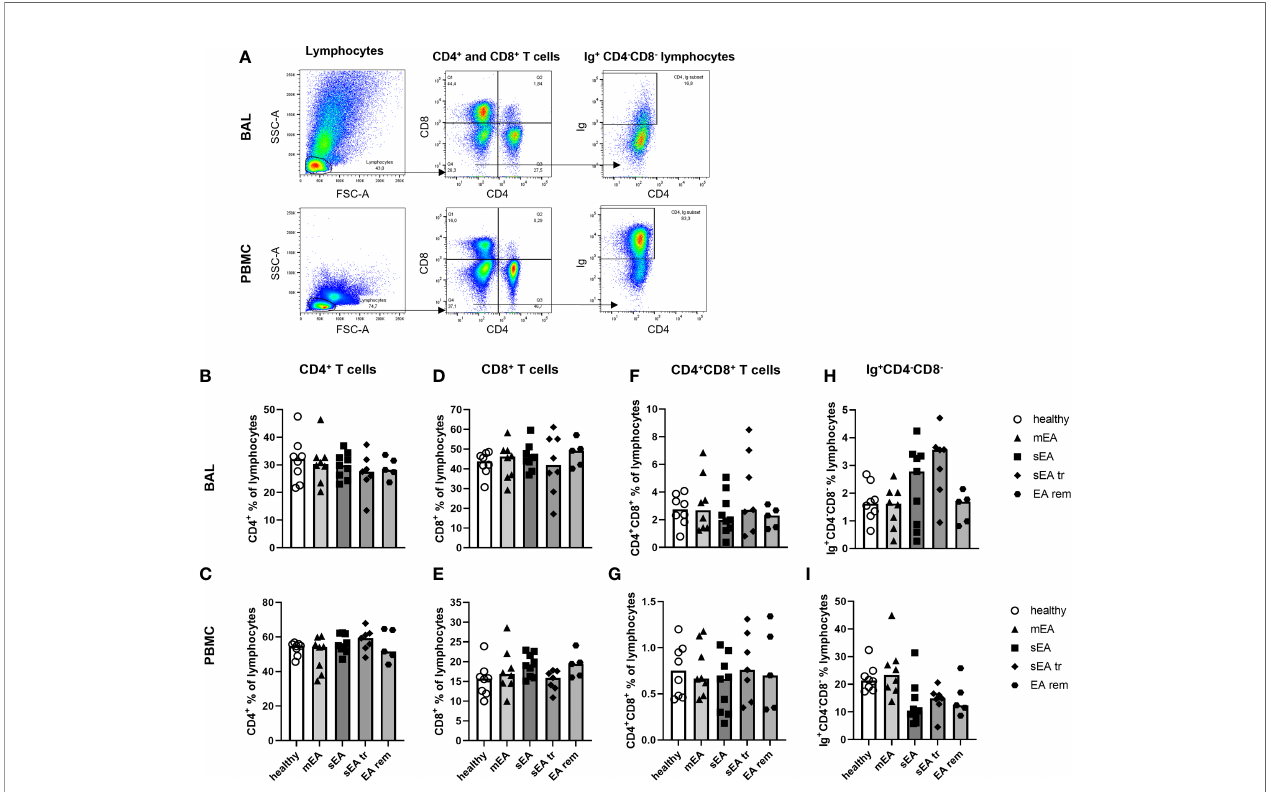
FIGURE 5 | Proportions of CD4 + T cells, CD8 + T cells, and Ig + lymphocytes are different in BAL cells and PBMC, but similar between groups. (A) Representative fl ow cytometry plots for gating of lymphocyte populations are depicted for samples from one horse with severe equine asthma (sEA). CD4 + T cells (B, C) , CD8 + T cells (D, E) , CD4 + CD8 + T cells (F, G) , as well as Ig + CD4 - CD8 - lymphocytes (H, I) were detected at similar frequencies among BAL cells or PBMC from horses of all groups. Values of individual horses are shown with bars indicating group medians. Mind the different scales of the Y-axes. mEA (mild to moderate equine asthma), sEA (severe equine asthma), tr (pre-treated with steroids or bronchodilators), EA rem (equine asthma in